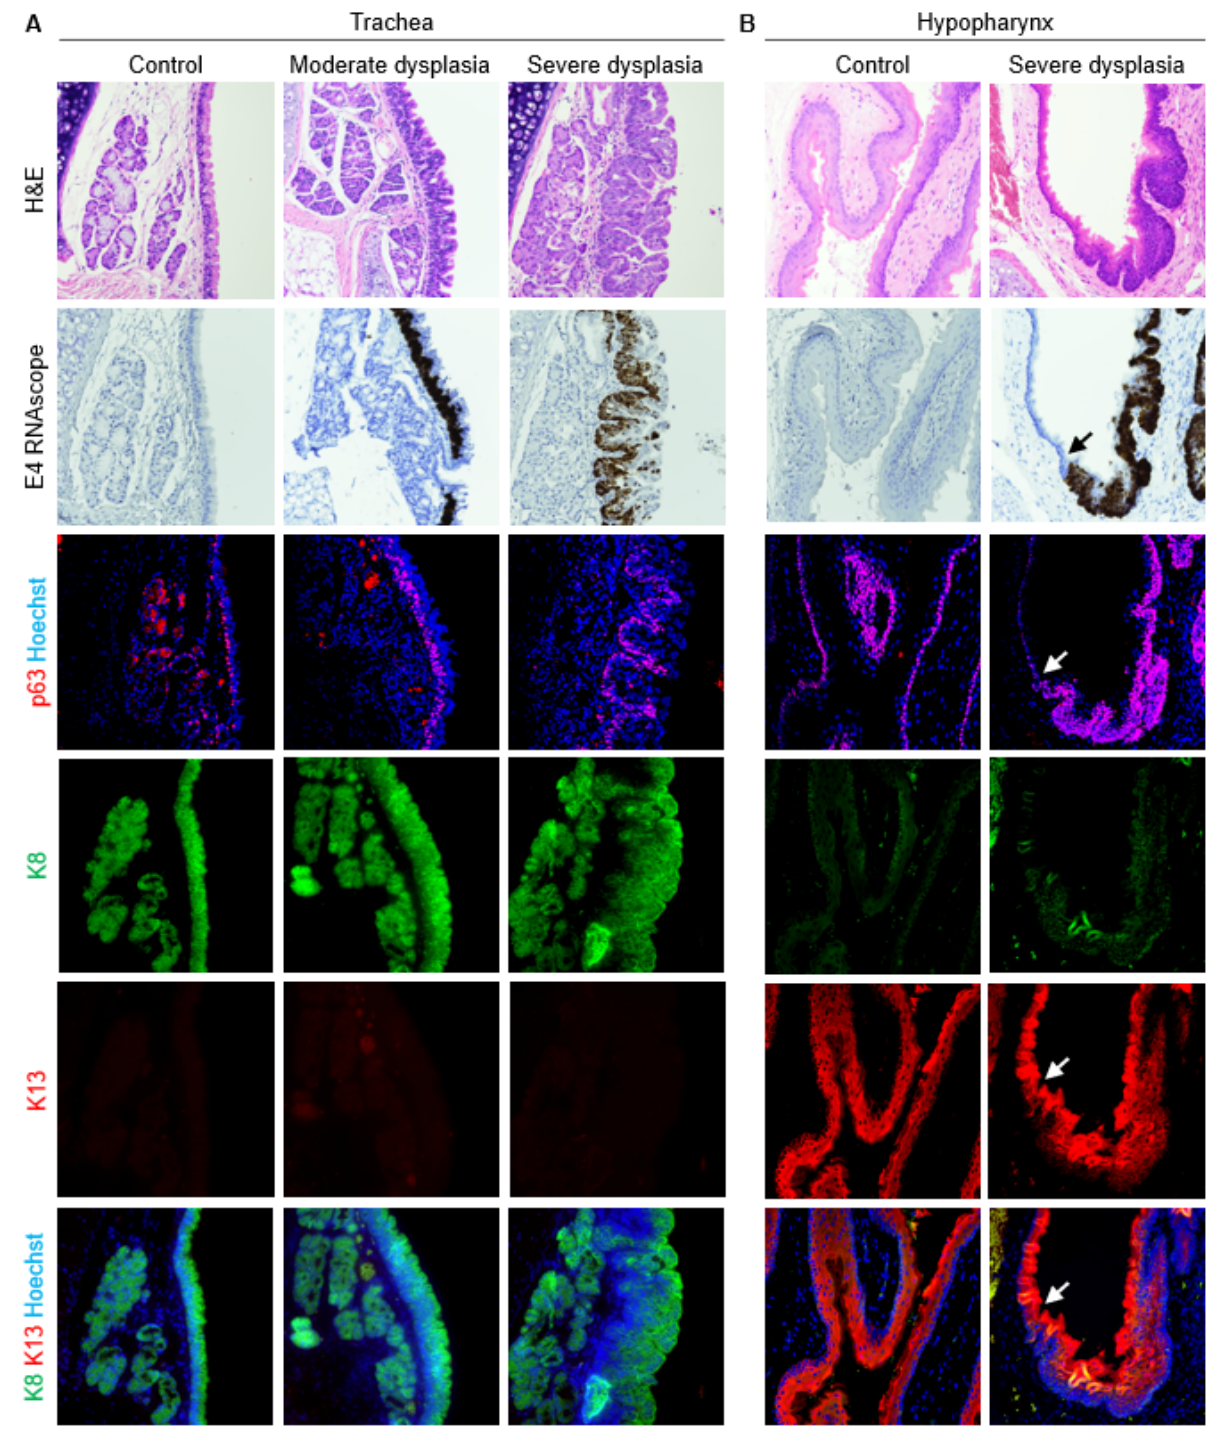
Figure 6. Expanded epithelial basal compartment in MmuPV1-induced disease in proximal trachea and hypopharynx. Serial sections of control and diseased tissues stained with H&E, MmuPV1 E4 RNAscope ISH, costained p63 (red) and Hoechst (blue) IF, and costained K8 (green), K13 (red), and Hoechst (blue) IF shown both as separate channels and merged. 40× magnification. Some H&E and RNAscope images reproduced with permission from our companion paper [3]. ( A ) Trachea. ( B ) Hypopharynx. Arrows indicate transition between normal, nondiseased epithelium and dysplastic, MmuPV1-positive epithelium coinciding with expanded basal compartment.